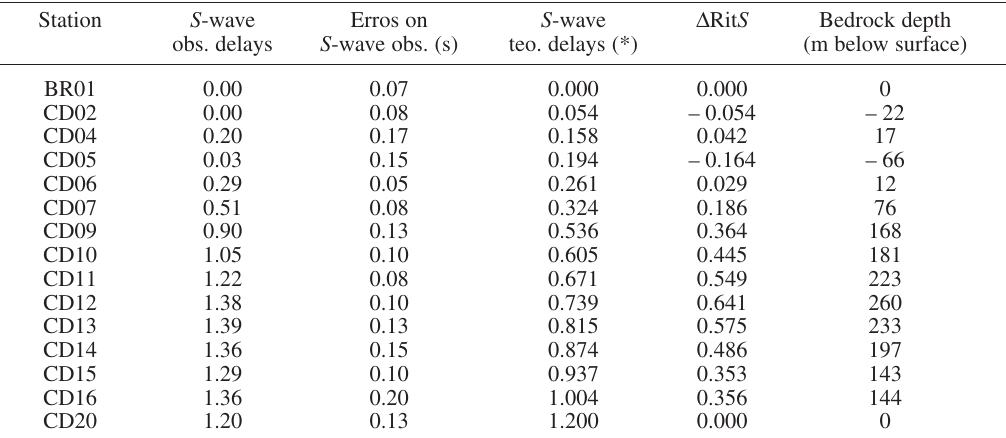
(*) Topographic correction is included.